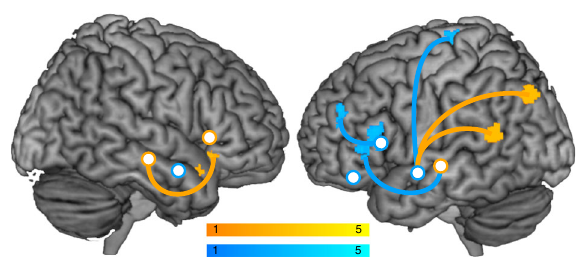
Fig. 4 Resting-state functional connectivity in response to spectral and temporal adaptation. Intrahemispheric resting-state functional connectivity changes associated with the learning of new auditory-motor associations following spectral (orange) and temporal feedback perturbations (blue) (perturbation vowel ∩ perturbation consonant ), cluster level corrected for multiple comparisons at p < 0.05 FWE with a cluster forming threshold of p < 0.001 (one-sided, paired t- test, n = 22 participants per group, color represents t -values, see color scales). Seed regions (white circles) are based on functional activation maxima during speaking with spectrally (orange) or temporally (blue) altered feedback compared to normal speaking (see Fig. 3b and Table 1). Note that the right inferior frontal cluster extends from the lateral surface into the orbitofrontal cortex, which seemingly gives rise to two clusters. Spectral adaptation also increased connectivity between L aSTS and L IPS and between R pSTS and HG (Table 3, these deeper structures are not rendered on the surface).